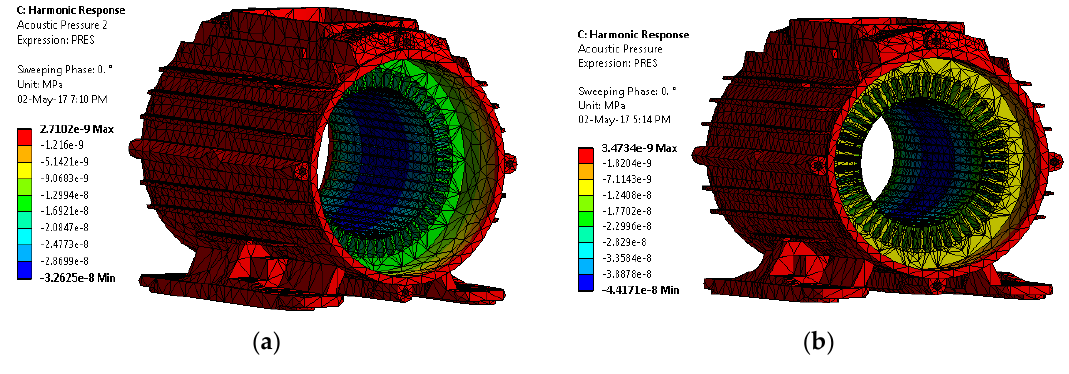
Figure 15. Acoustic versus frequency plot.